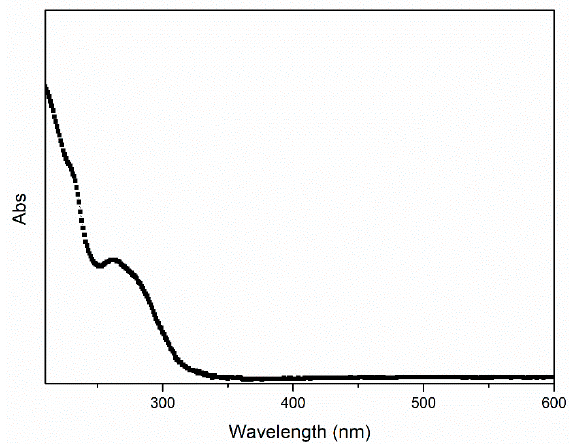
Figure 3. UV-Vis spectrum in a mixture of 1 mg/L of sulfamethoxazole (SMX), carbamazepine (CBZ) and lorazepam (LRZ).